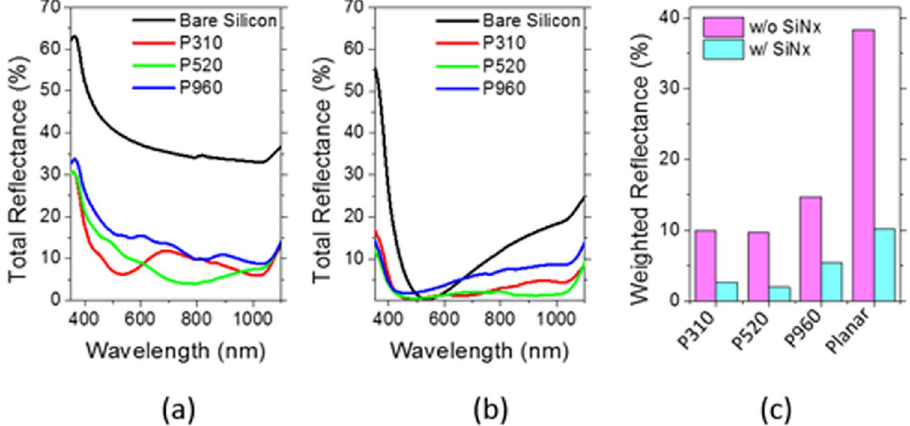
Figure 5. Reflectance curves of Si wafers with parabolic Si nanostructures ( a ) before and ( b ) after SiN x deposition. Three different sizes of silica beads (P310, P520, P960) were used for RIE masks. Average reflectance values of the Si wafers with parabolic Si nanostructures before and after SiN x deposition. Reflectance values of planar Si wafers (bare Si) without nanostructures are also shown together for comparison.